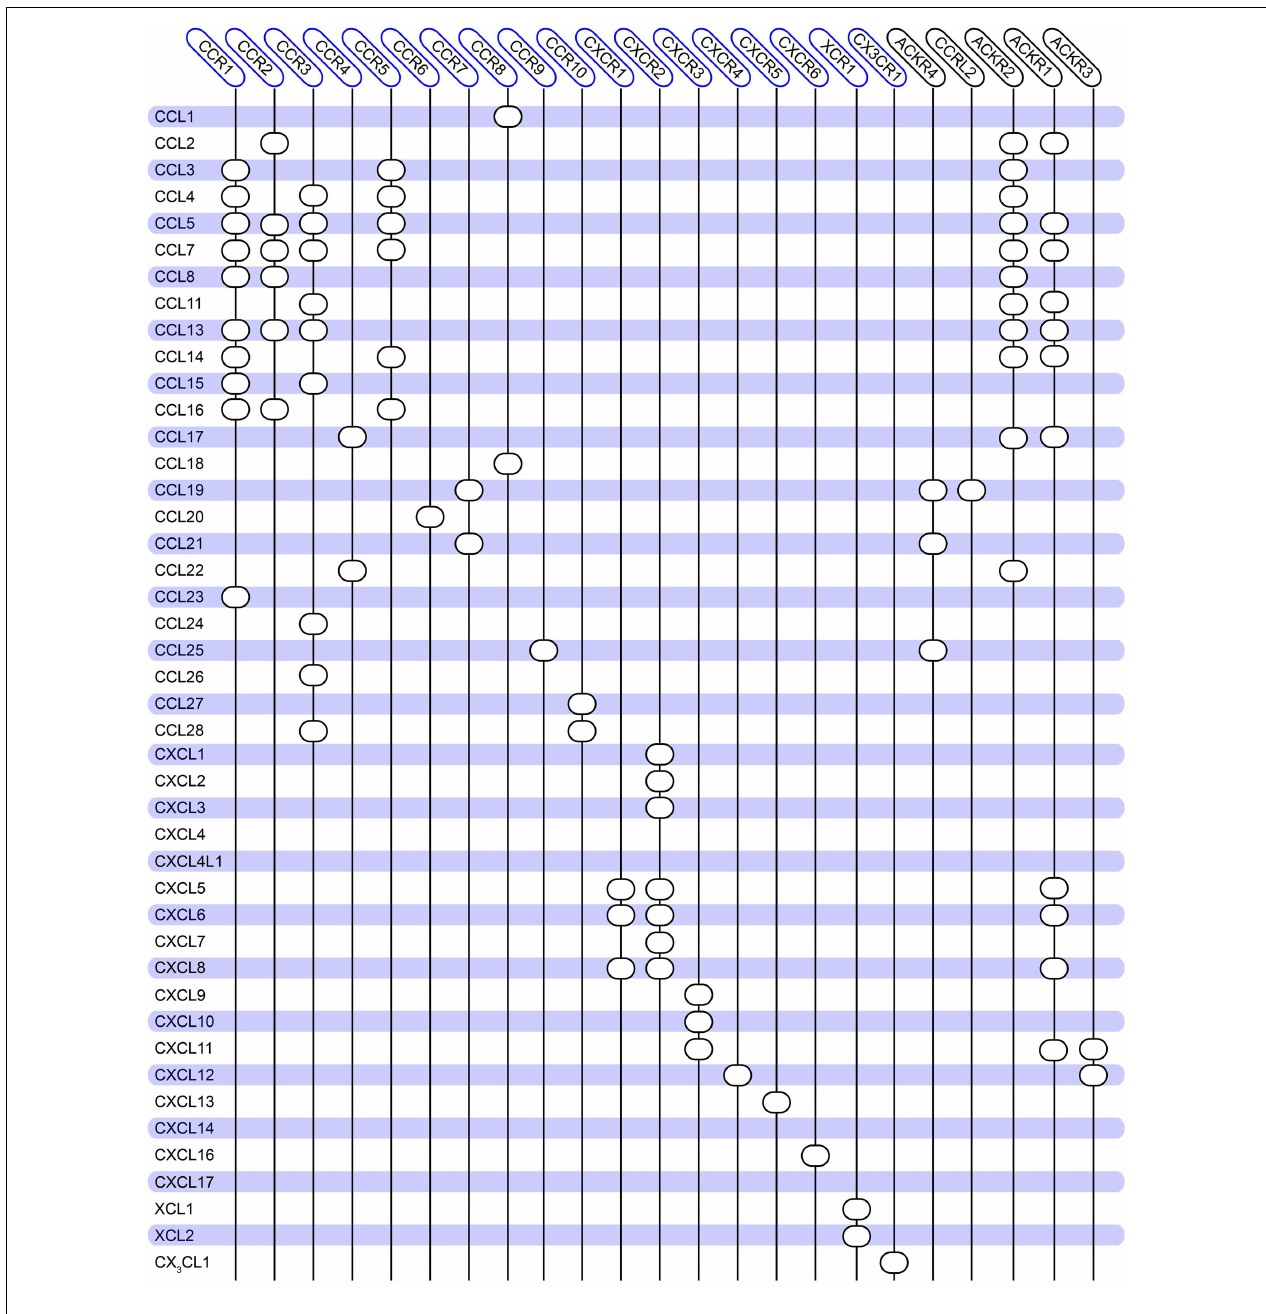
reported for CCL18, CXCL4, and CXCL14. Atypical chemokine receptors are boxed in black on the right.The diagram is constructed based on (144) and updated to match the database from IUPHAR (2) and the NCBI gene bank 1 .